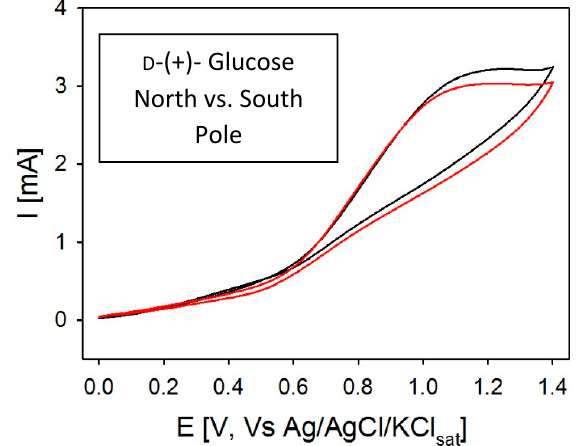
Figure 6. Comparison between cyclic voltammetry curves recorded with electrodeposited Ni on both poles of the magnet. Red curve : South pole with 0.1 M of d -( + )-Glucose in KOH 0.1 M aqueous solution. Black curve : North pole with 0.1 M of d -( + )-Glucose in KOH 0.1 M aqueous solution. 50 mV / s potential scan rate, Pt as CE, Ag / AgCl / KCl as RE.